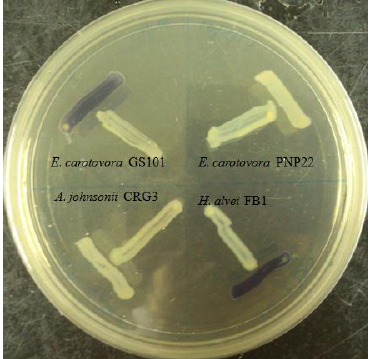
Figure 1. Screening for AHL production using C. violaceum CV026 cross streaking with E. carotovora GS101 and PNP22 as positive and negative controls, respectively. H.